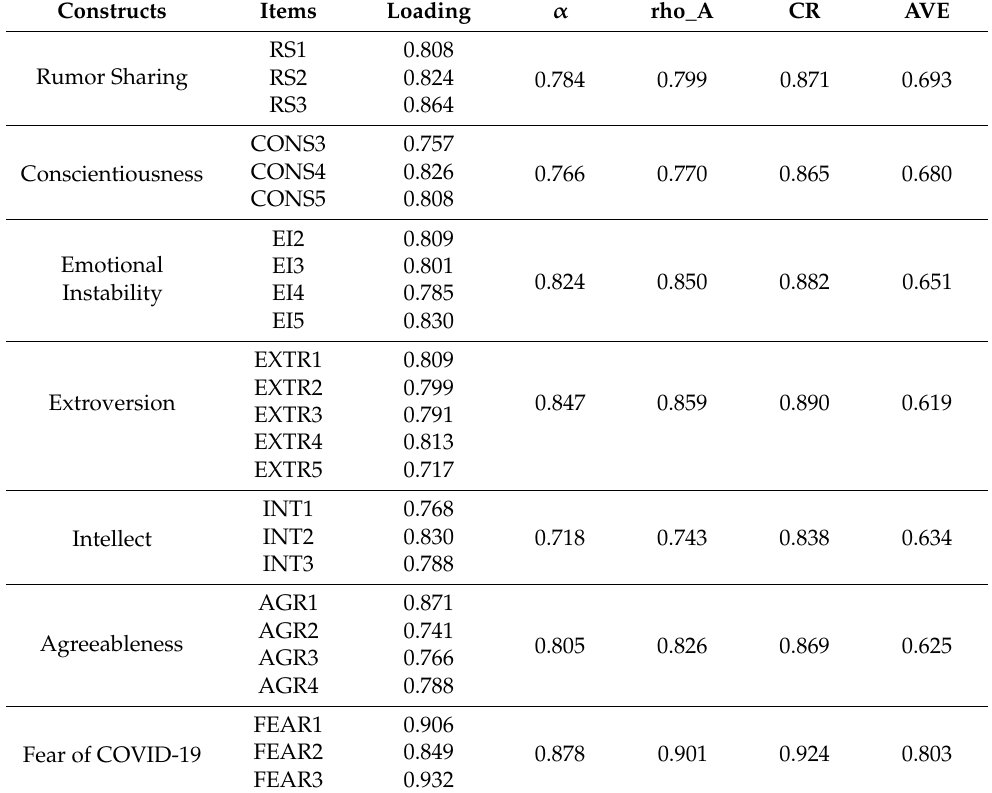
Table 3. Reliability and validity analysis.